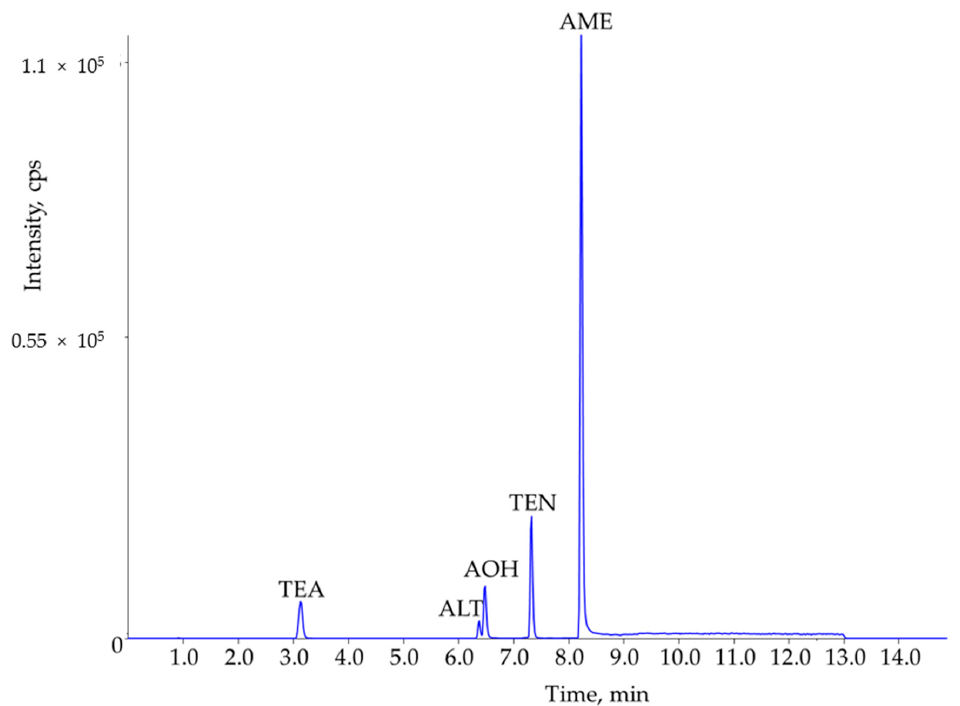
Figure 1. Total ion chromatogram of a tomato juice sample spiked with AOH, AME, and ALT in 2.0 µ g/kg concentration and with TEA and TEN in 40 µ g/kg concentration.